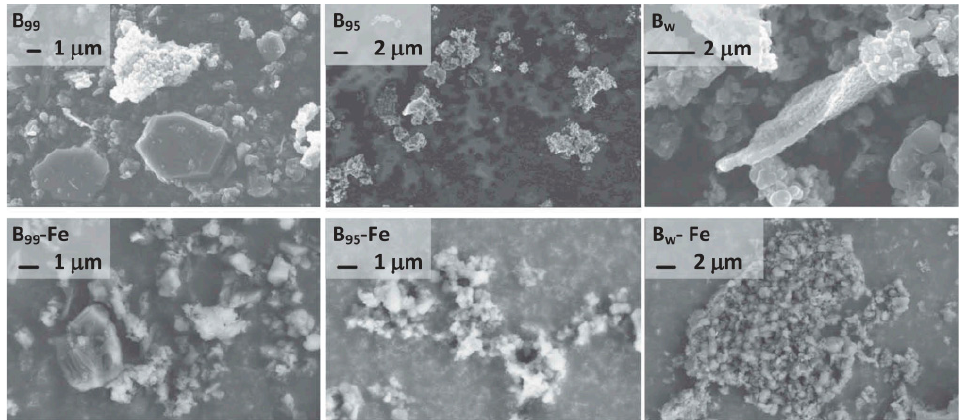
Figure 2. SEM images of boron-based materials: Top: Uncoated boron with different purities (sec- ondary electron images); Bottom: Iron-coated boron with different purities and surface modifications (back-scattered electron images). Reprinted with permission from Ref. [52]. Copyright 2021 Taylor &